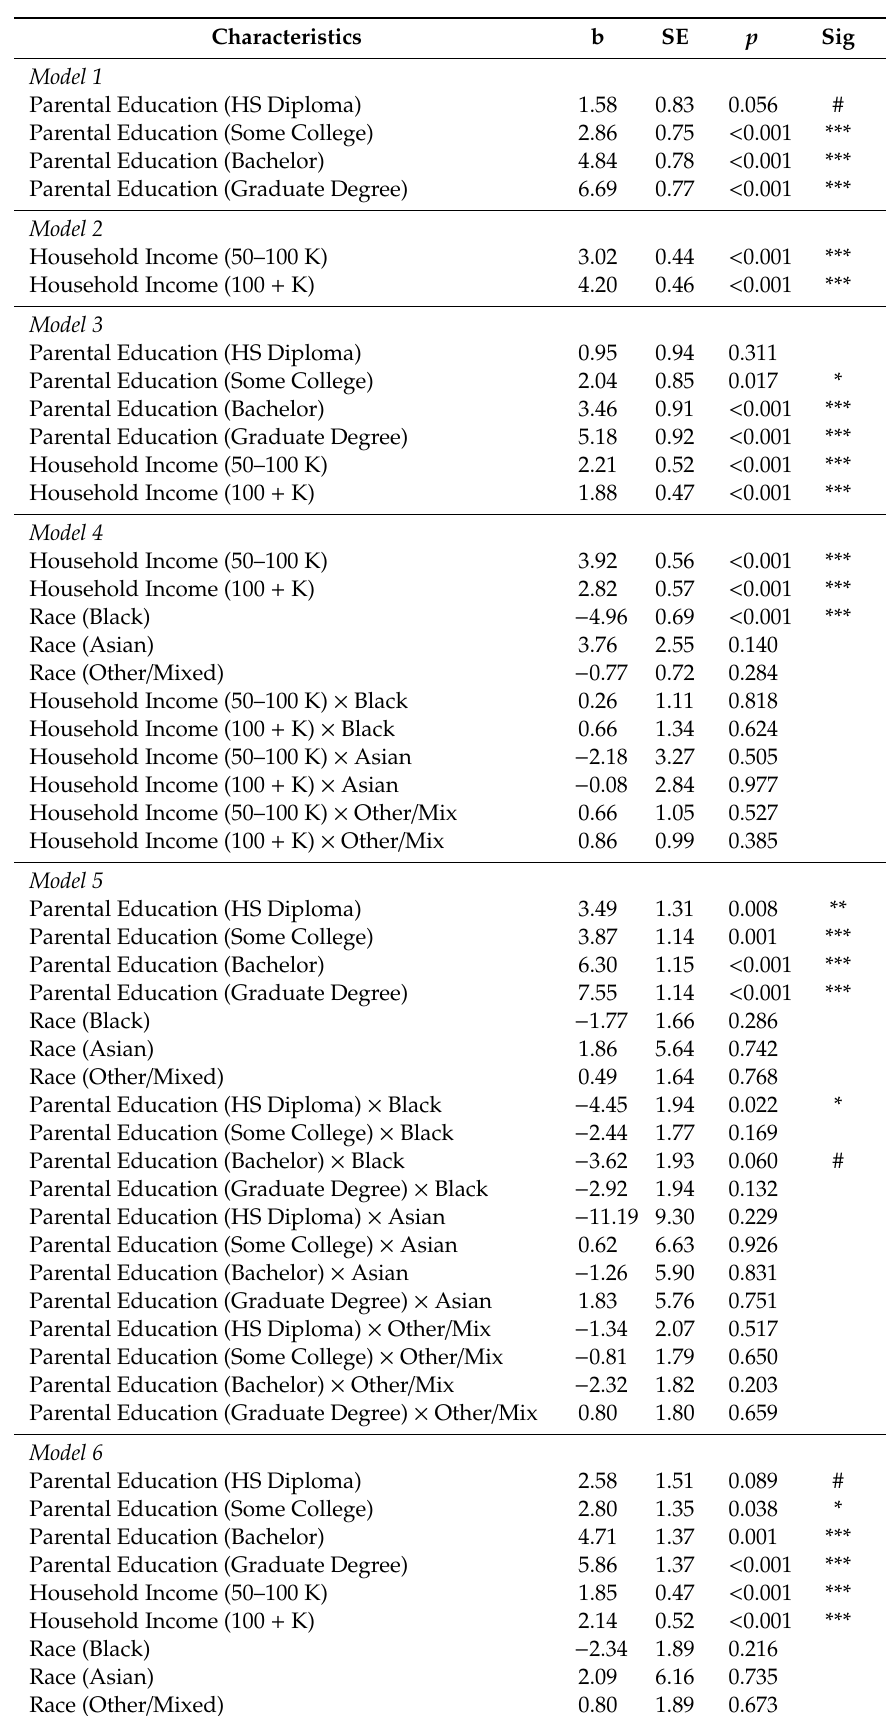
Table 3. Mixed-e ff ects regressions in the pooled sample ( n = 10418).